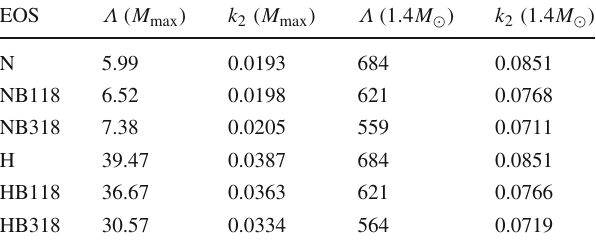
Table 3 Deformabilities and Love numbers for the maximum and the canonical